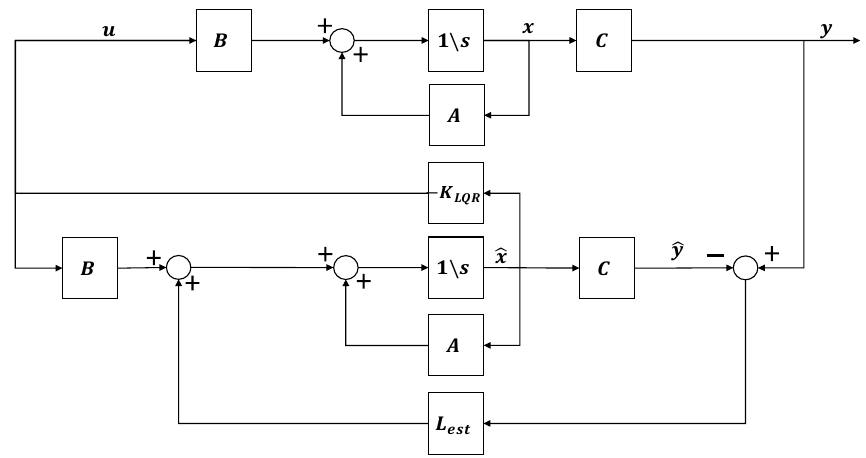
Figure 5. Block diagram representation of the state feedback control system with state estimator.